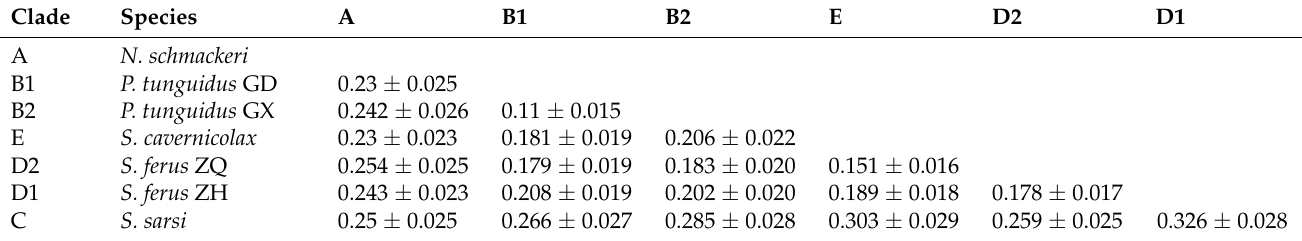
Table 2. Range of maximum likelihood genetic distance (Kimura two-parameter model) between genera and lower-order clades, average ±